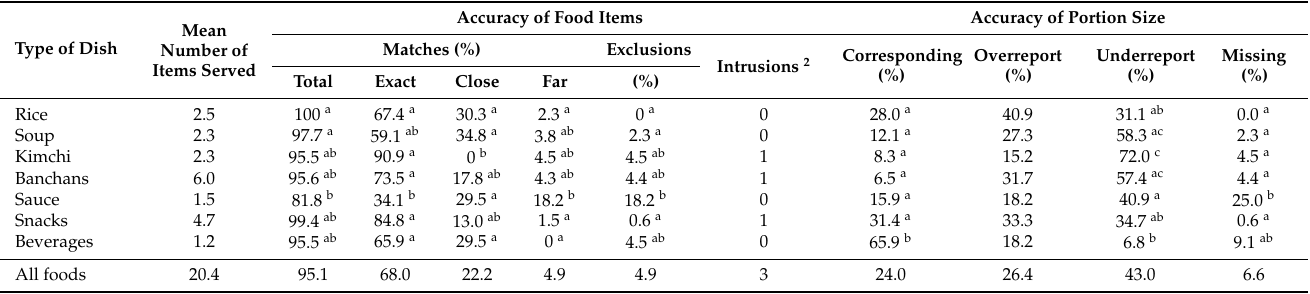
Table 3. Accuracy of food items and portion size of 24-h diet recalls in relation to actual intake according to the type of dish among older Korean women ( n = 22) 1